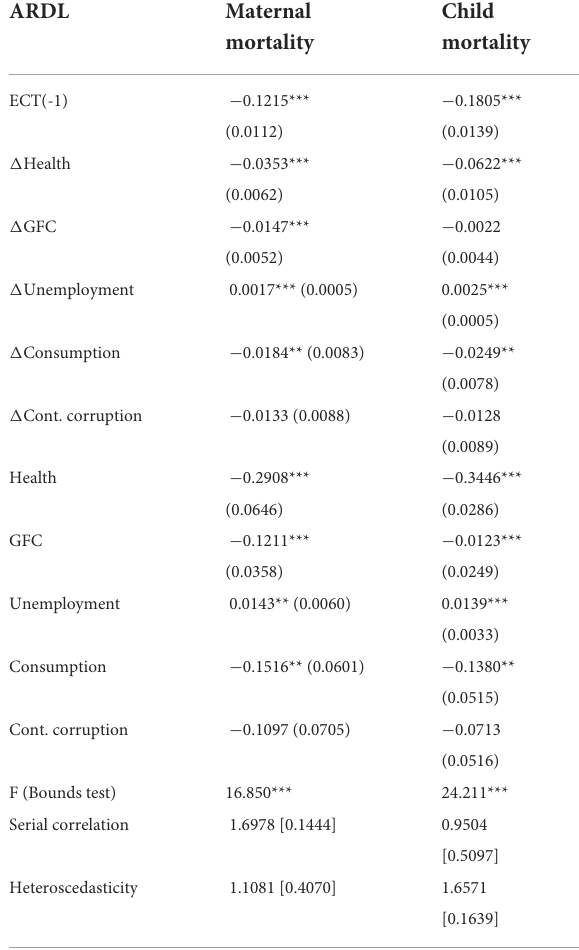
TABLE 1 The effect of macro-economic determinants on health